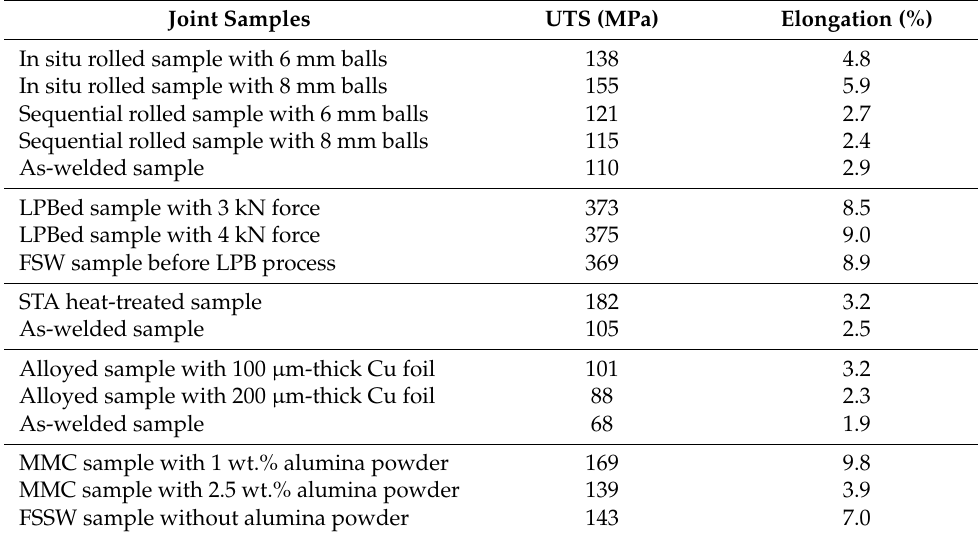
Table 2. Tensile test results of FSW/FSSW samples before and after post-processing.